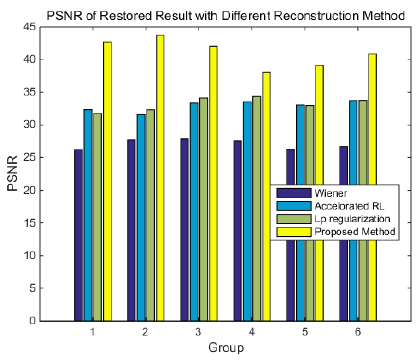
Figure 17. The PSNR of the different reconstruction methods.